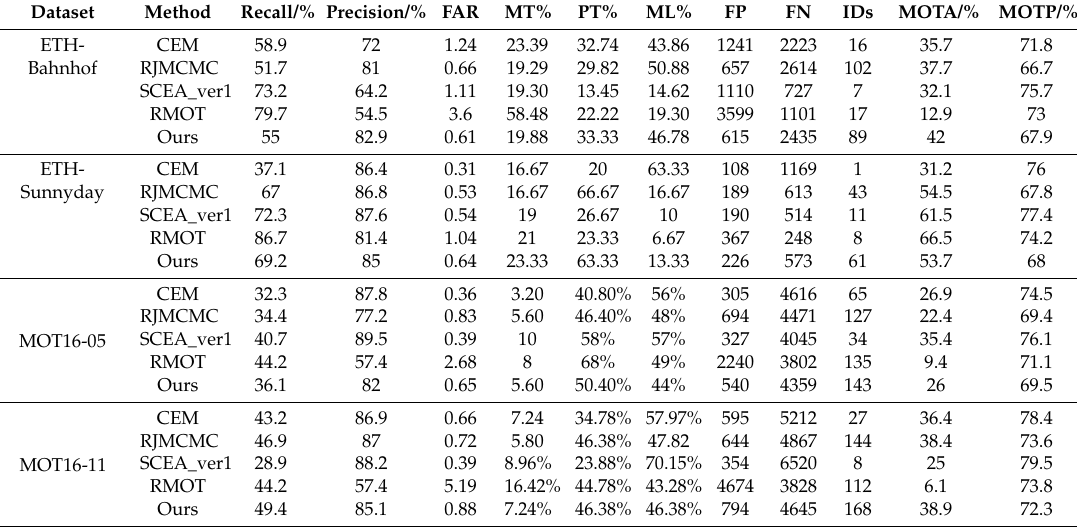
Table 3. Performance comparison of tracking in different video